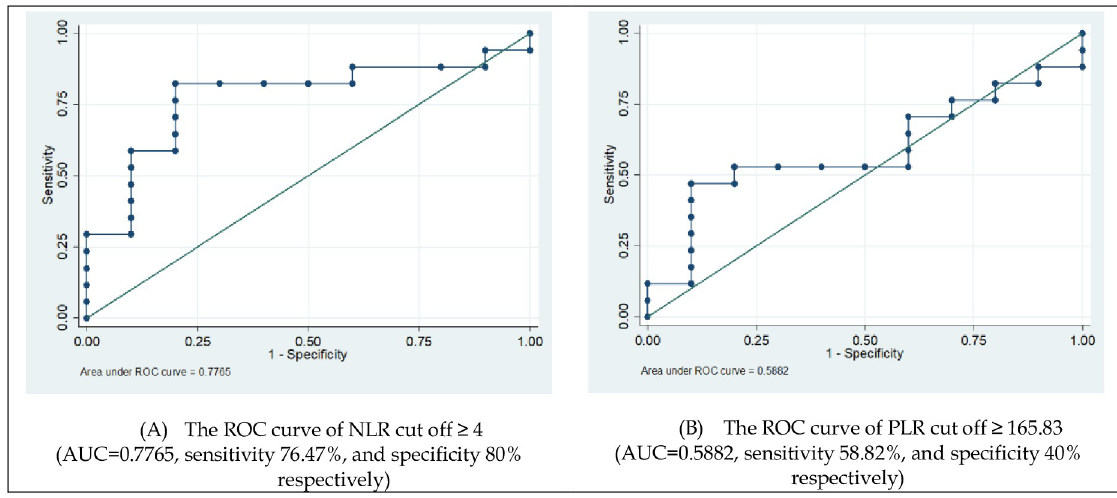
Fig 1. The ROC curve of NLR cut off � 4 and PLR cut off � 165.83 in HCC